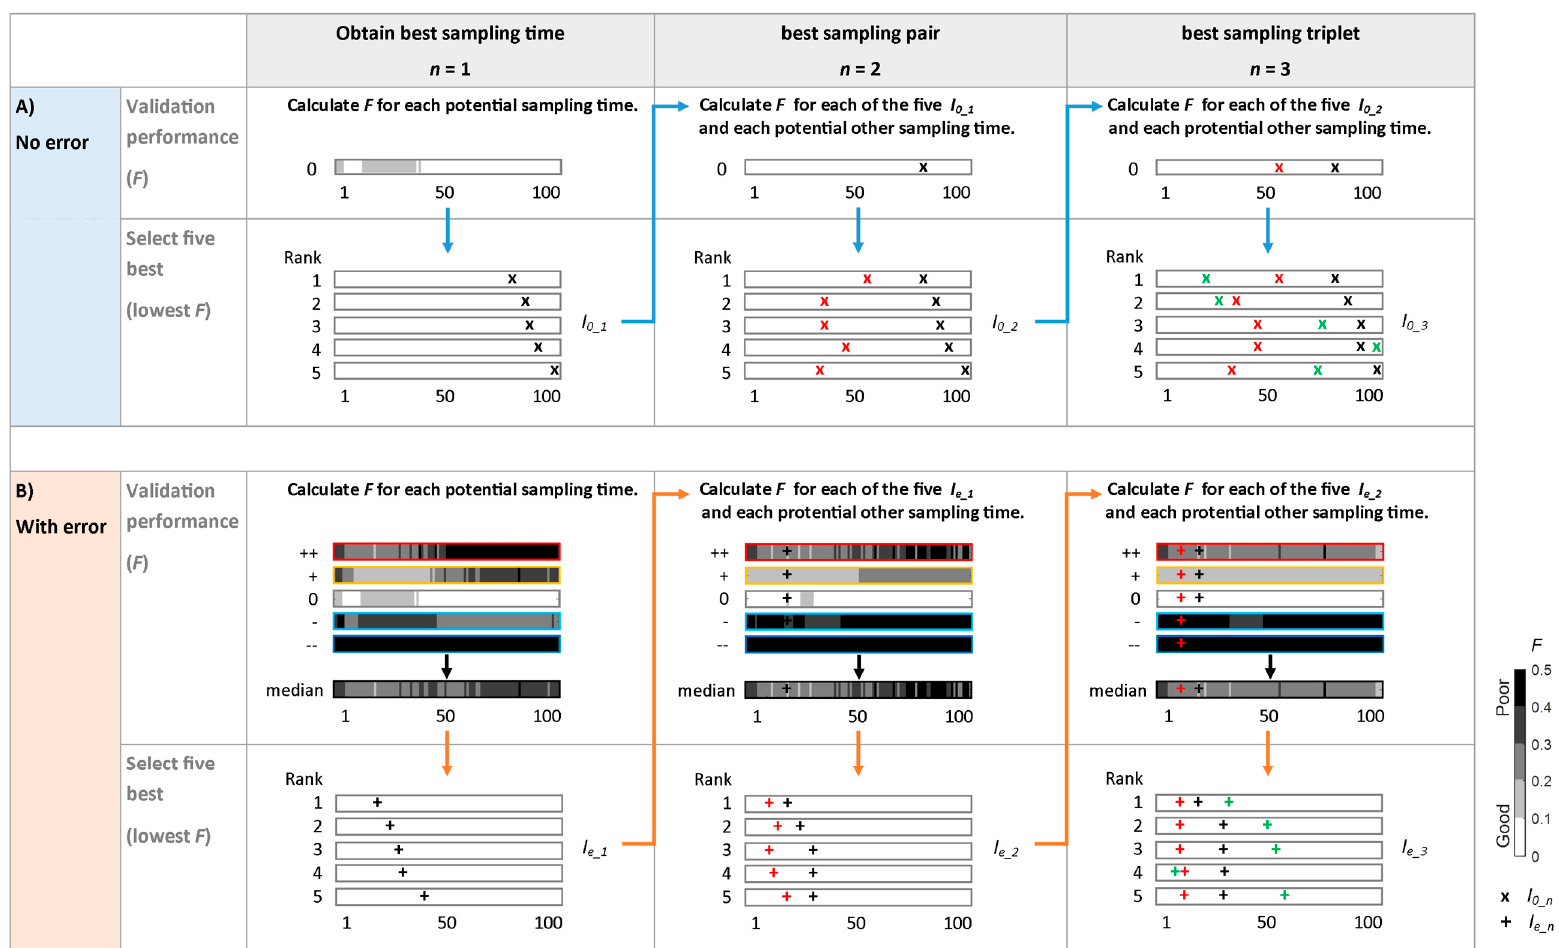
Figure 2. Illustration of the steps involved in determining the most informative sampling times when there are no data errors ( A : I 0_n ) and when there are data errors ( B : I e_n ). Note that I e_n was determined separately for each error type. No grey shading is shown for the case without errors ( A ) for the best sampling pairs and triplets due to the very good validation performance ( F was close to 0).